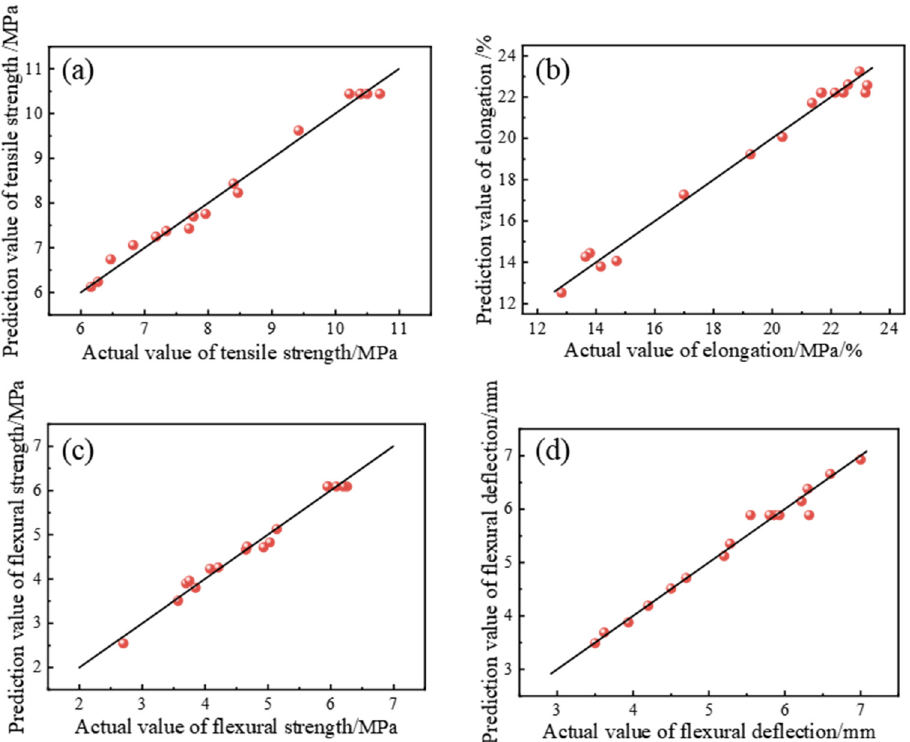
σ ε , ( b ) model t , ( c ) model f σ